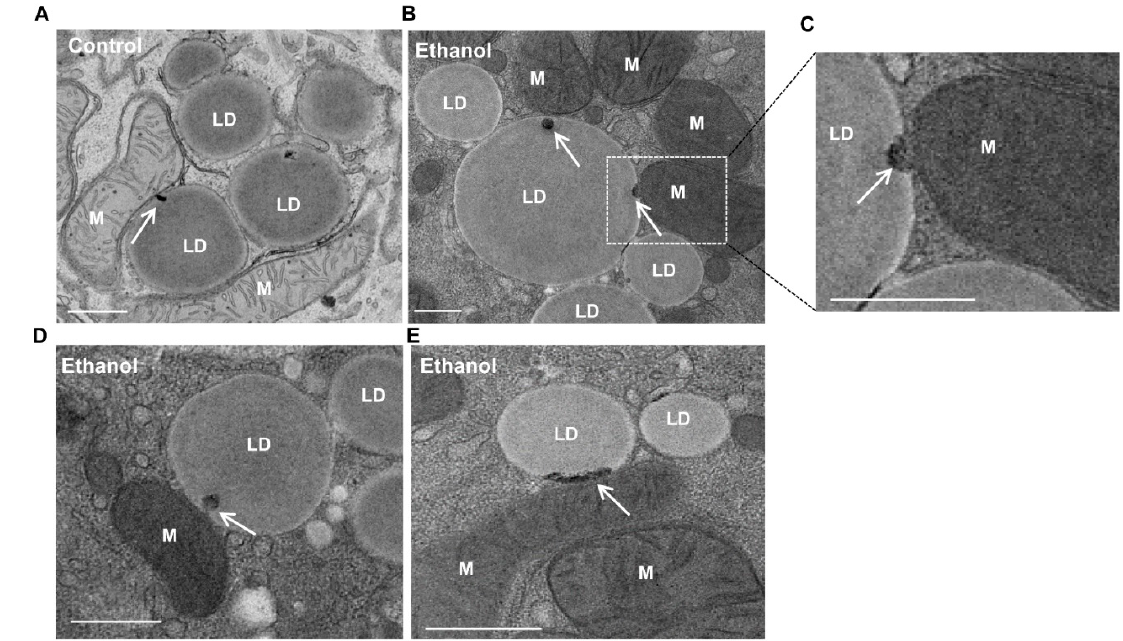
Figure 4. Dot- or tubular-like mitochondria–LD contact sites in primary cultured mouse hepatocytes. Primary mouse hepatocytes were either untreated ( A ) or treated with ethanol (100 mM, B – E ) for 6 h followed by EM analysis. ( A – E ) Representative EM images from untreated control hepatocytes ( A ) or ethanol-treated hepatocytes ( B – E ) are shown. ( C ) Enlarged image from the boxed areas in B. White arrows denote electron-dense dot- and tubular-like mitochondria–LD contact sites. LD: lipid droplet; M: mitochondria. Bar: 500 nm.